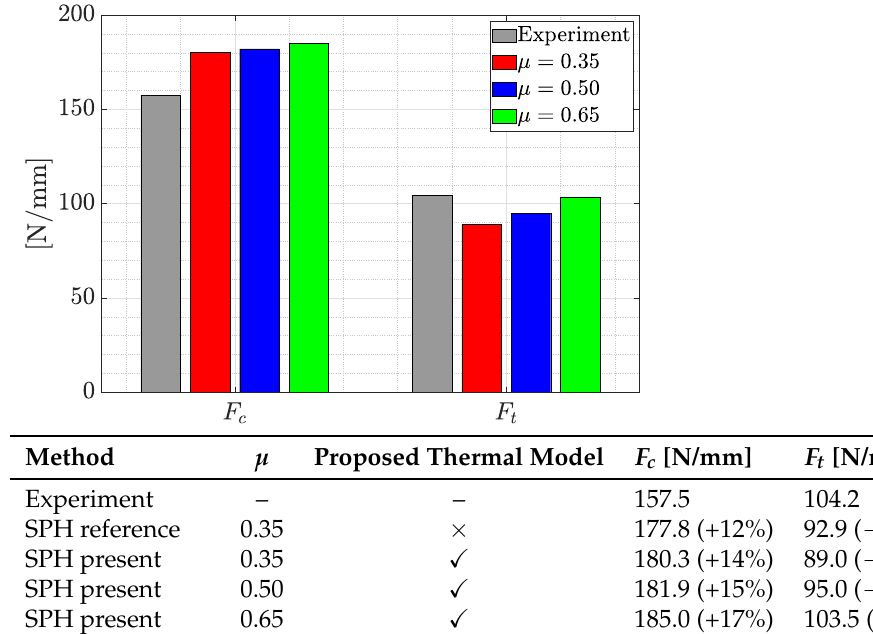
Figure 6. Summary of the measured and predicted forces for the cutting test. Forces predicted by SPH with different coefficients of friction are plotted in the bar chart, where the proposed thermal model is utilized. Impact of µ on the thrust forces is higher than the cutting forces, demonstrating the most accurate result when µ = 0.65 is